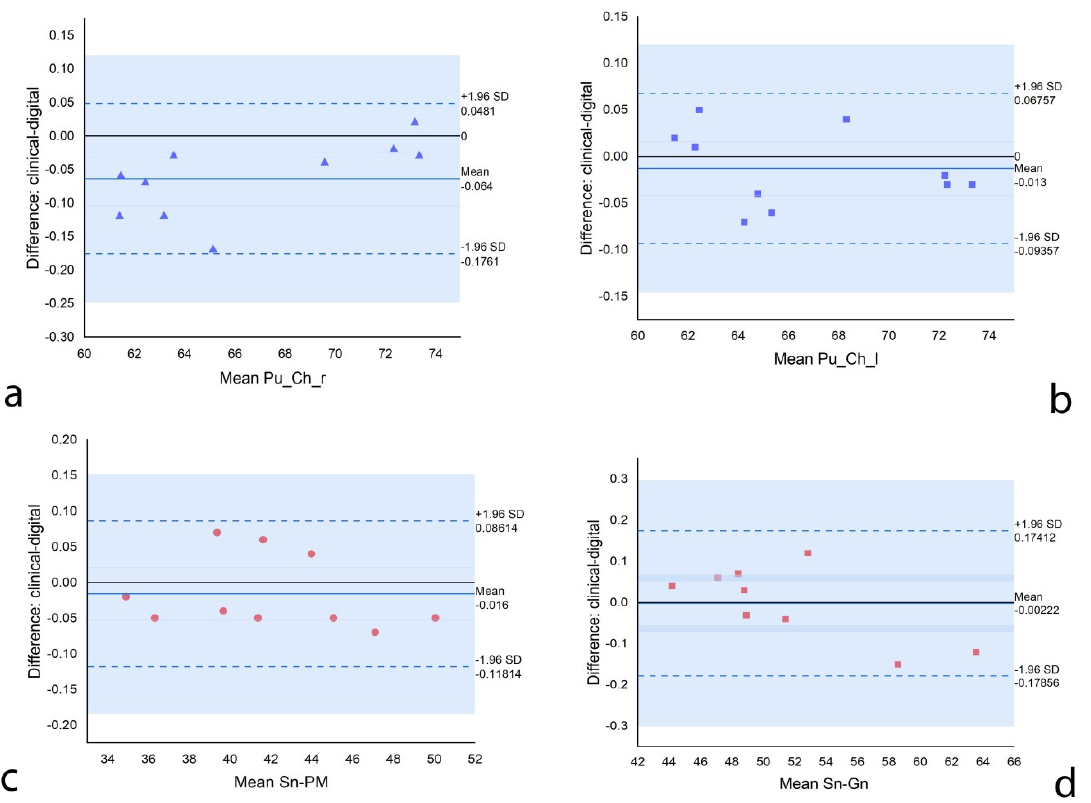
Figure 5. Bland–Altman plots showing the extent of agreement between the clinically performed anthropometric measurements and the corresponding measurement made on the facial scans in Exocad software for: ( a ) right pupil [Pu] to right buccal commissure (chelion [Ch]) (Pu–Ch_r), ( b ) left pupil to left buccal commissure (Pu–Ch_l), ( c ) Subnasion [Sn] to Prementon [PM] (Sn–PM) and ( d ) Subnasion [Sn] to Gnathion [Gn] (Sn–Gn), in maximum intercuspation position.